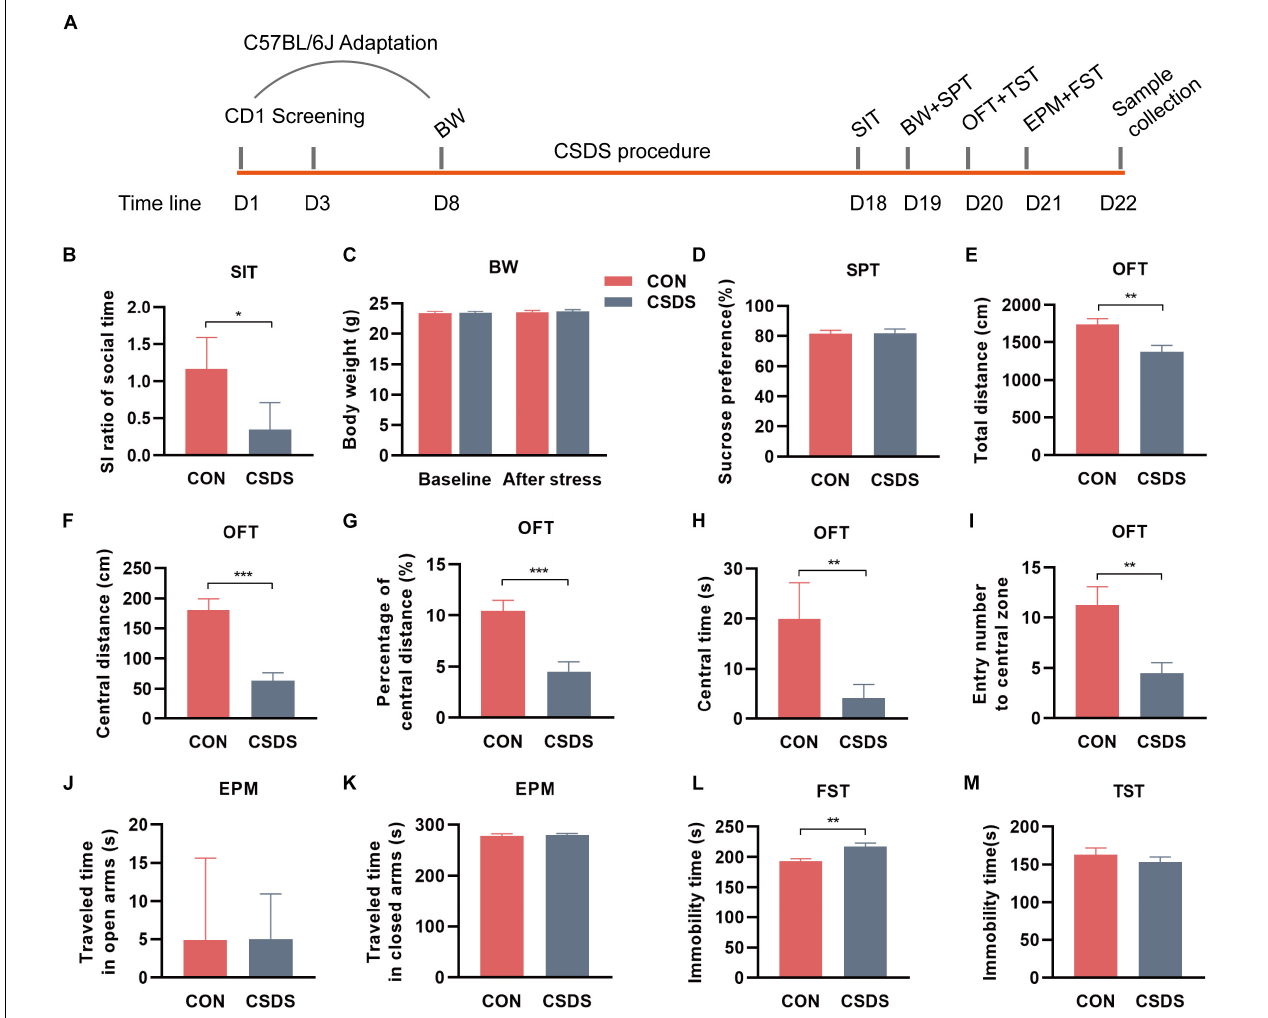
FIGURE 1 | Experimental schedule and assessments of behavior indices. (A) Schedule of the CSDS procedure. During the first week, C57BL/6J mice were kept in experimental cages for environmental adaptation, and meanwhile, CD1 mice underwent the screening process. After the adaptation, C57BL/6J mice in the CSDS group were subjected to 10 consecutive days of CSDS exposure. After 4 days of behavioral tests (SI, BW, SPT, OFT, and FST), all C57BL/6J mice were sacrificed. (B) SIT: Mice in the CSDS group showed a significantly lower SI ratio than those in the control group. (C) BW: No significant difference was observed at baseline or after social defeated stress. (D) SPT: No significant difference was observed between the CSDS and control groups. (E–I) OFT: Mice in the CSDS group showed a significantly reduced total distance, central distance, percentage of central distance, central time, and entry number to the central zone than those in the control group. (J,K) EPM: No significant difference was observed in the time traveling in open or closed arms. (L) FST: Mice in the CSDS group showed a significantly increased immobility time than the control group. (M) TST: No significant difference was observed between the two groups. When the data conformed to normal distribution and homogeneity of variance, two-tail Student t -test was used and data are presented as mean ± SEM. Otherwise, the non-parametric Mann–Whitney U test was required and data are presented as median ± interquartile range ( n = 10 mice in each group). * p < 0.05, ** p < 0.01, *** p < 0.001, ns, no significance. CON, mice in the control group; CSDS, mice in the CSDS